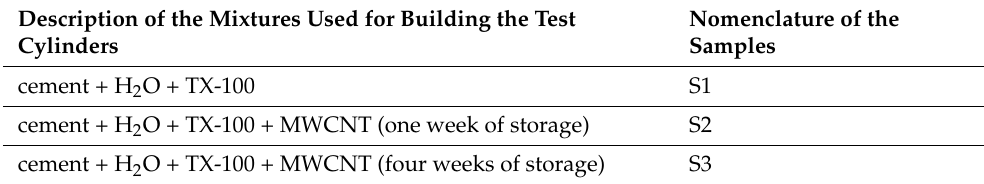
Table 2. Description and notation of the samples used for the mechanical properties characterization.